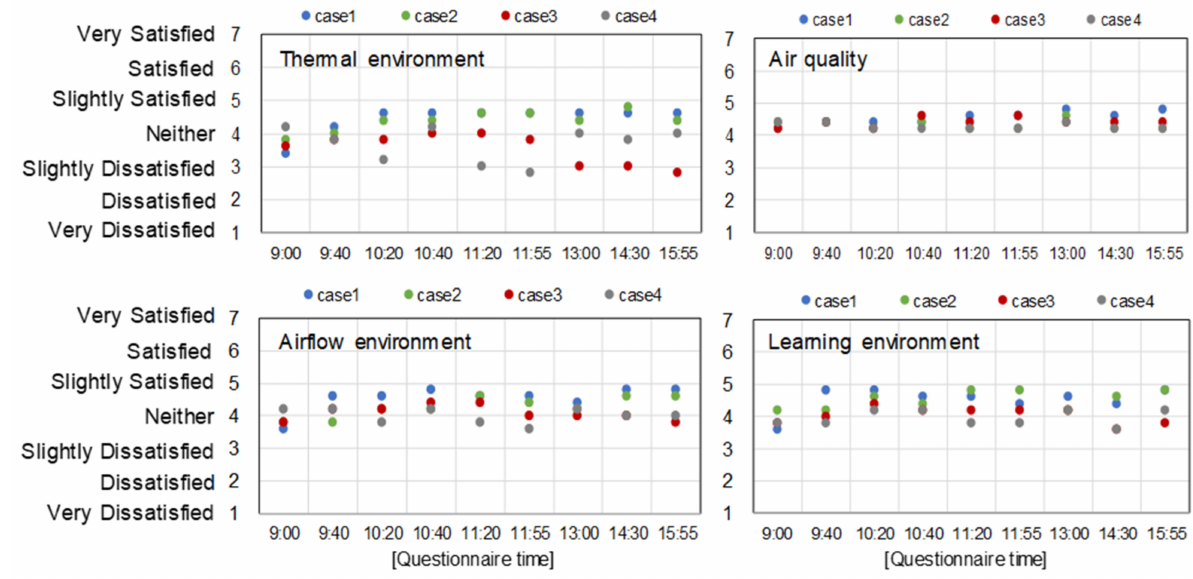
Figure 6. Satisfaction with the indoor environment in